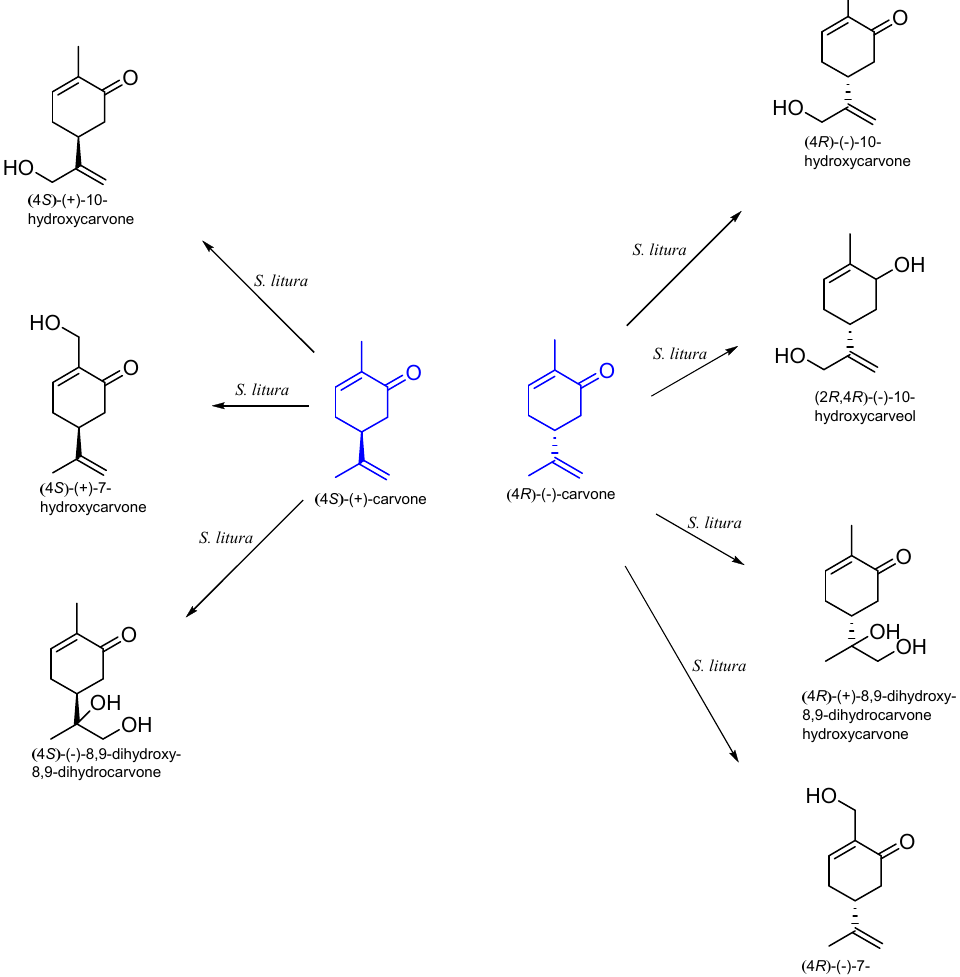
Scheme 18. Biotransformation of (4 S )-(+)-carvone and (4 R )-( − )-carvone by